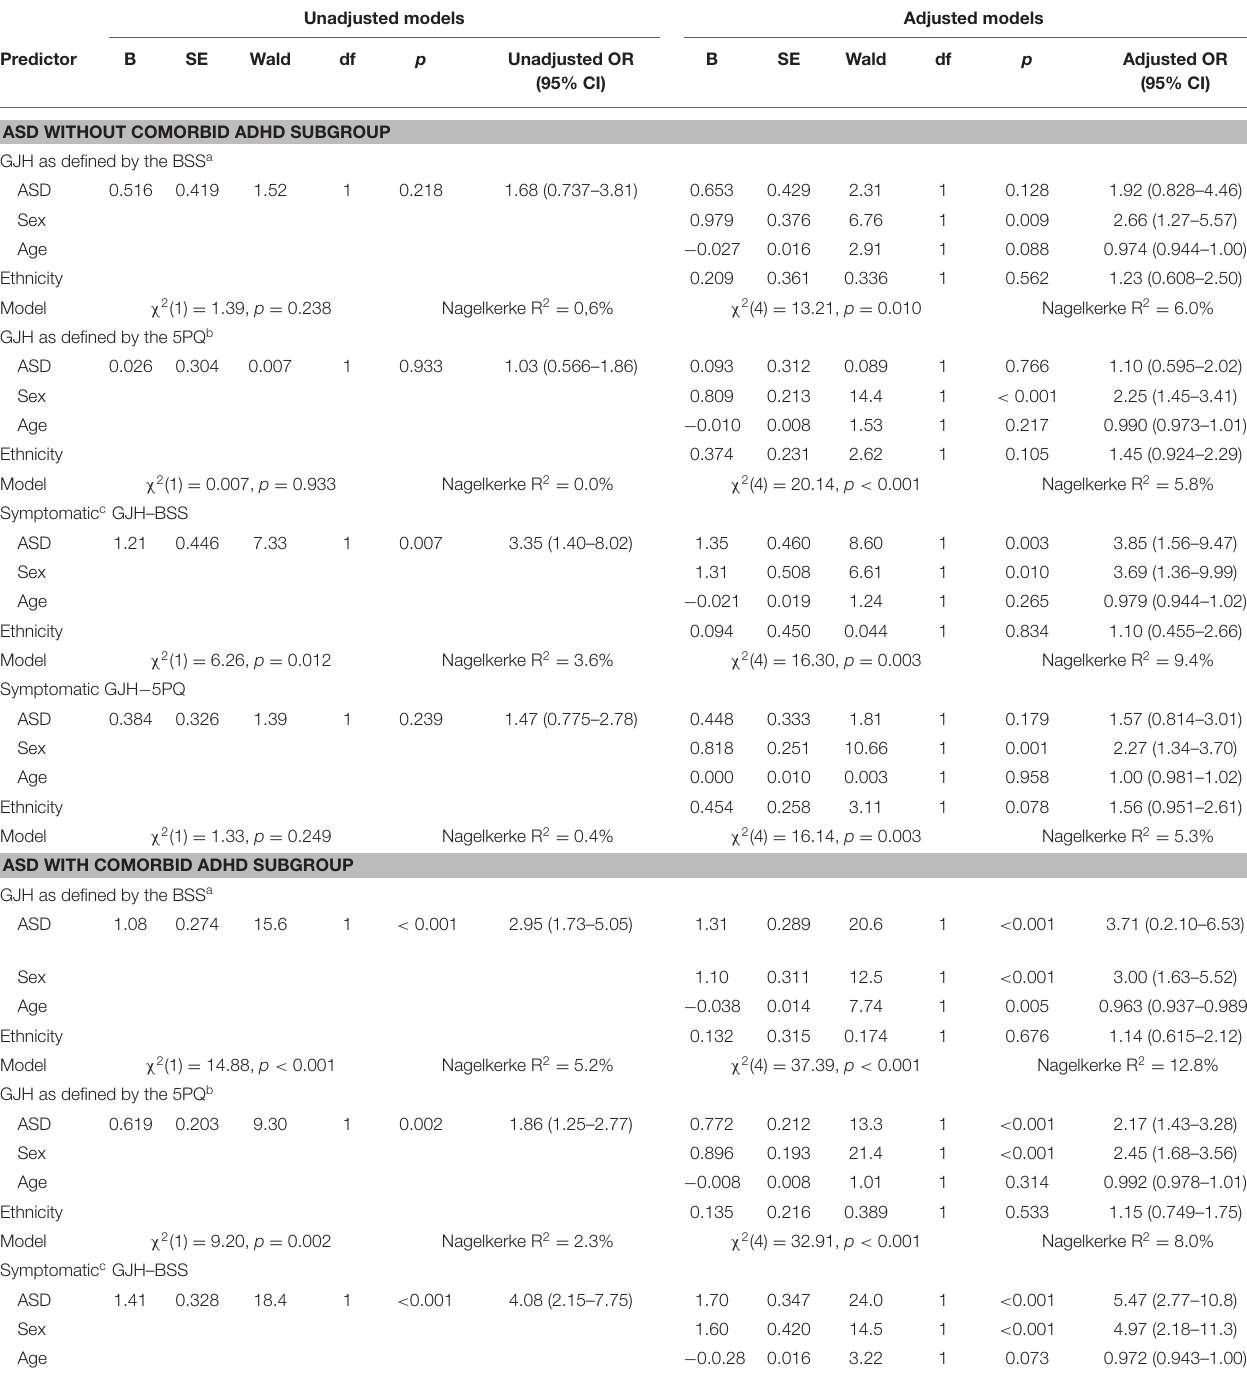
TABLE 4 | Subgroup analyses on ASD with and without comorbid ADHD: Results of the logistic regression models on ASD diagnosis relationship with generalised joint hypermobility. Unadjusted